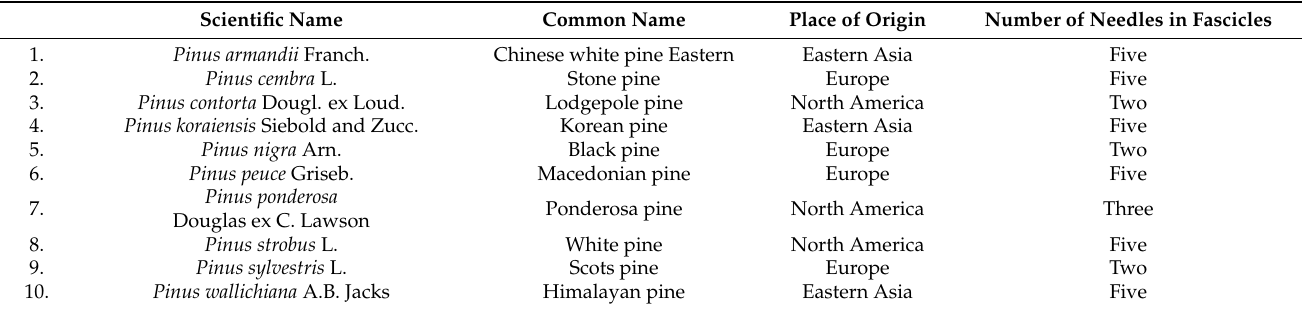
Table 1. Pine species that were selected for this